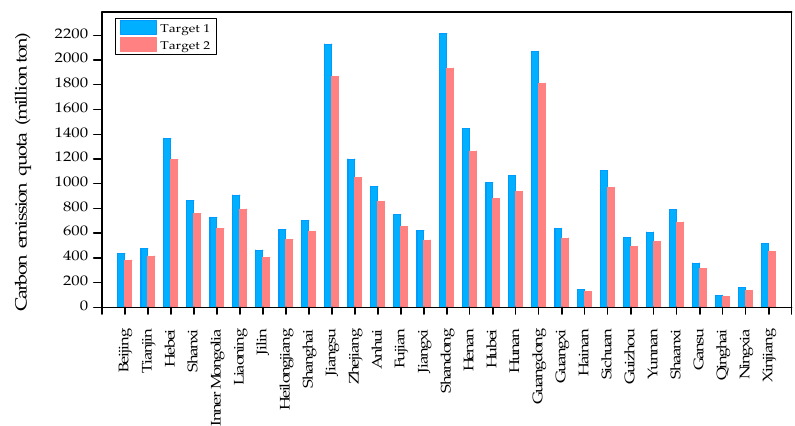
Figure 5. The carbon emission quotas of each region.